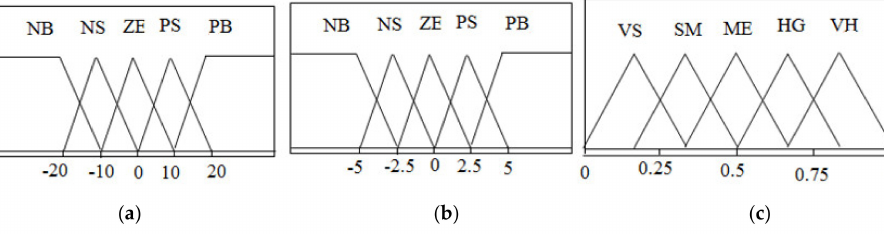
Figure 9. Membership function of the VFOFLC: ( a ) input error; ( b ) input change in power; ( c ) output duty